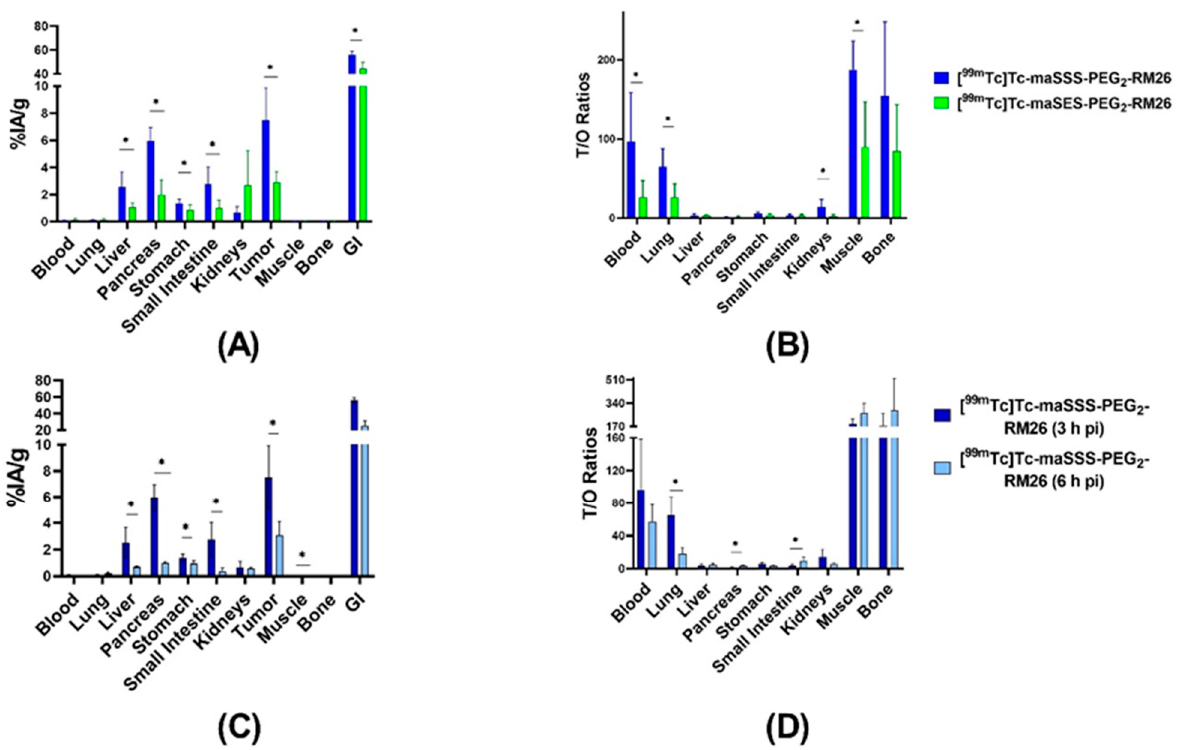
Figure 6. Biodistribution of [ 99m Tc]Tc-maSSS-PEG 2 -RM26 and [ 99m Tc]Tc-maSES-PEG 2 -RM26 in BALB/C nu/nu mice bearing PC-3 xenografts: The biodistribution ( A ) and the tumor-to-organ ratios ( B ) for [ 99m Tc]Tc-maSSS-PEG 2 -RM26 (blue) and [ 99m Tc]Tc-maSES-PEG 2 -RM26 (green) at 3 h pi. The biodistribution ( C ) and the tumor-to-organ ratios ( D ) for [ 99m Tc]Tc- maSSS-PEG 2 -RM26 at 3 h pi (dark blue) and 6 h pi (light blue). The uptake in the gastrointestinal tract with content (GI) is presented as %IA. The error bars represent the standard deviation. * indicates a significant difference with a p -value < 0.05.